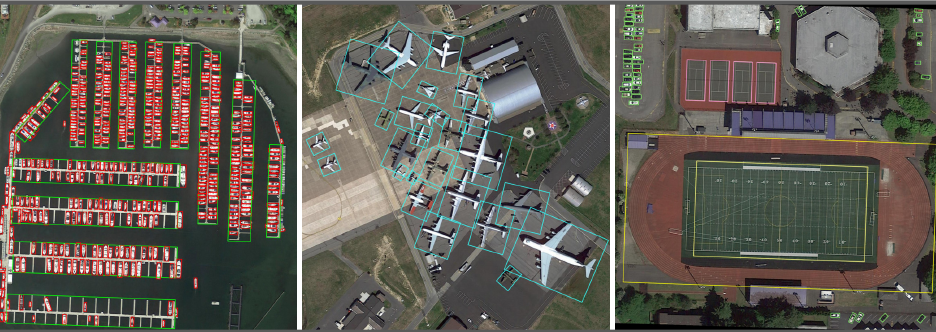
Figure 1. Examples of Low overlap and Densely arranged ( Left ), Arbitrary orientations of objects ( Middle ), and Drastic scale changes ( Right ) in remote sensing